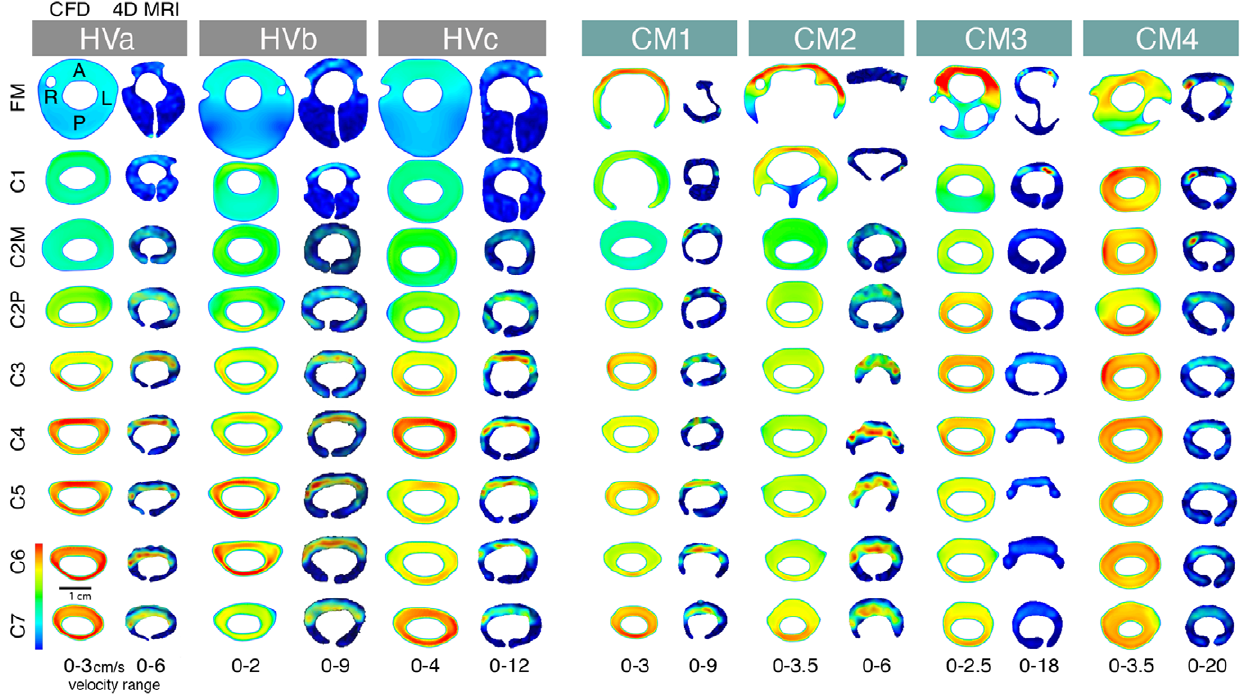
Figure 5. Thru-plane peak CSF velocity profiles (foot direction) at each axial location along the cervical spine. The left and right image for each subject corresponds to the CFD simulation and 4D PC MRI measurements along the cervical spine (FM-C7 level), respectively. CSF velocities were elevated in the anterior SSS in comparison to the posterior space in all of the 4D PC MRI velocity profiles (healthy and patients). The posterior versus anterior flow differences were not present in the CFD results; which maintained a fairly uniform velocity profile around the spinal cord in all simulations except CM 1 and CM 2 near the FM. Note, velocity scales are different for each image (shown at bottom of each image set) so as to highlight the difference in velocity profiles.